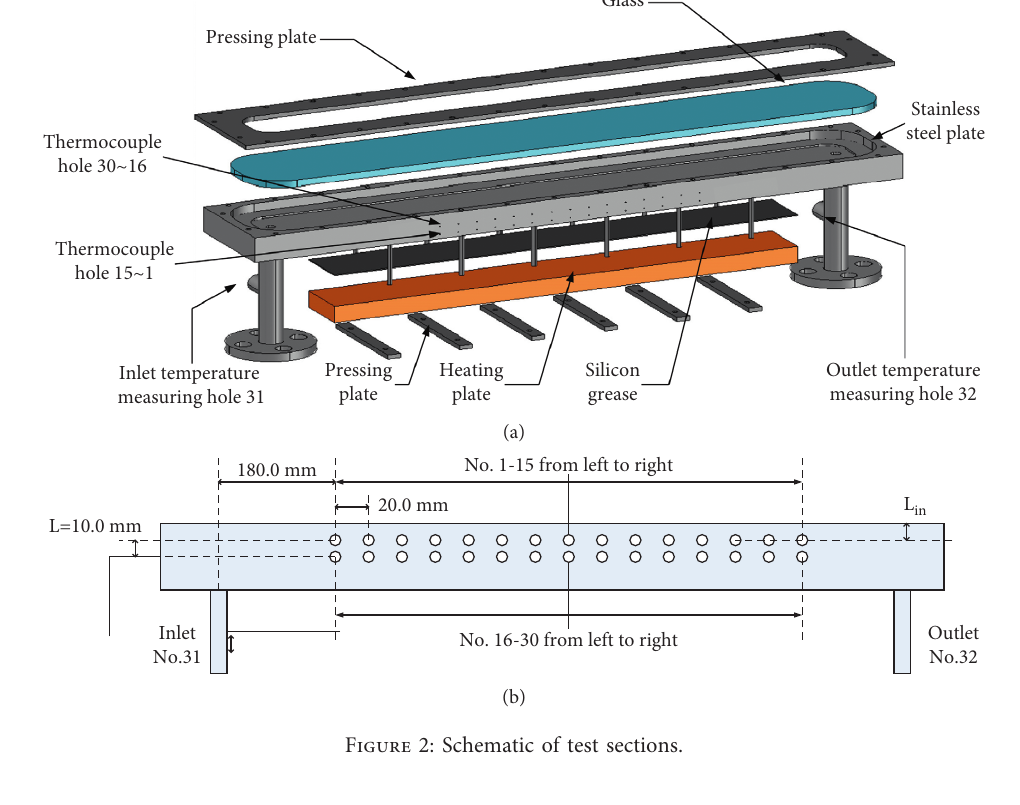
Figure 2: Schematic of test sections.